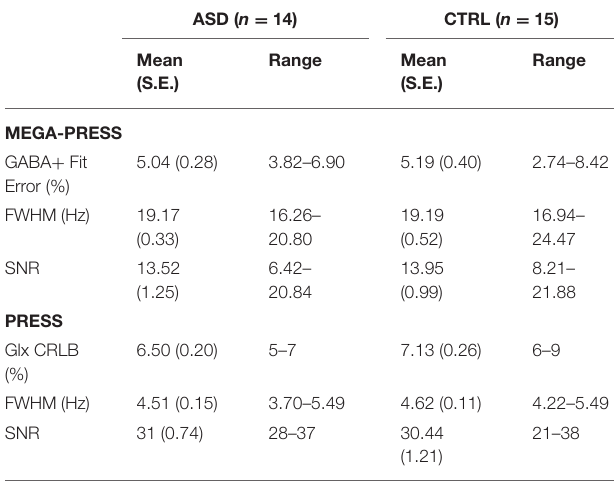
compared to control participants, with differences surviving FDR correction ( Z = − 2.400, p = 0.016, Figure 2A ), while corrected GABA + levels ( t (27) = − 1.032, p = 0.311, Figure 2B ) did not show significant differences between groups.